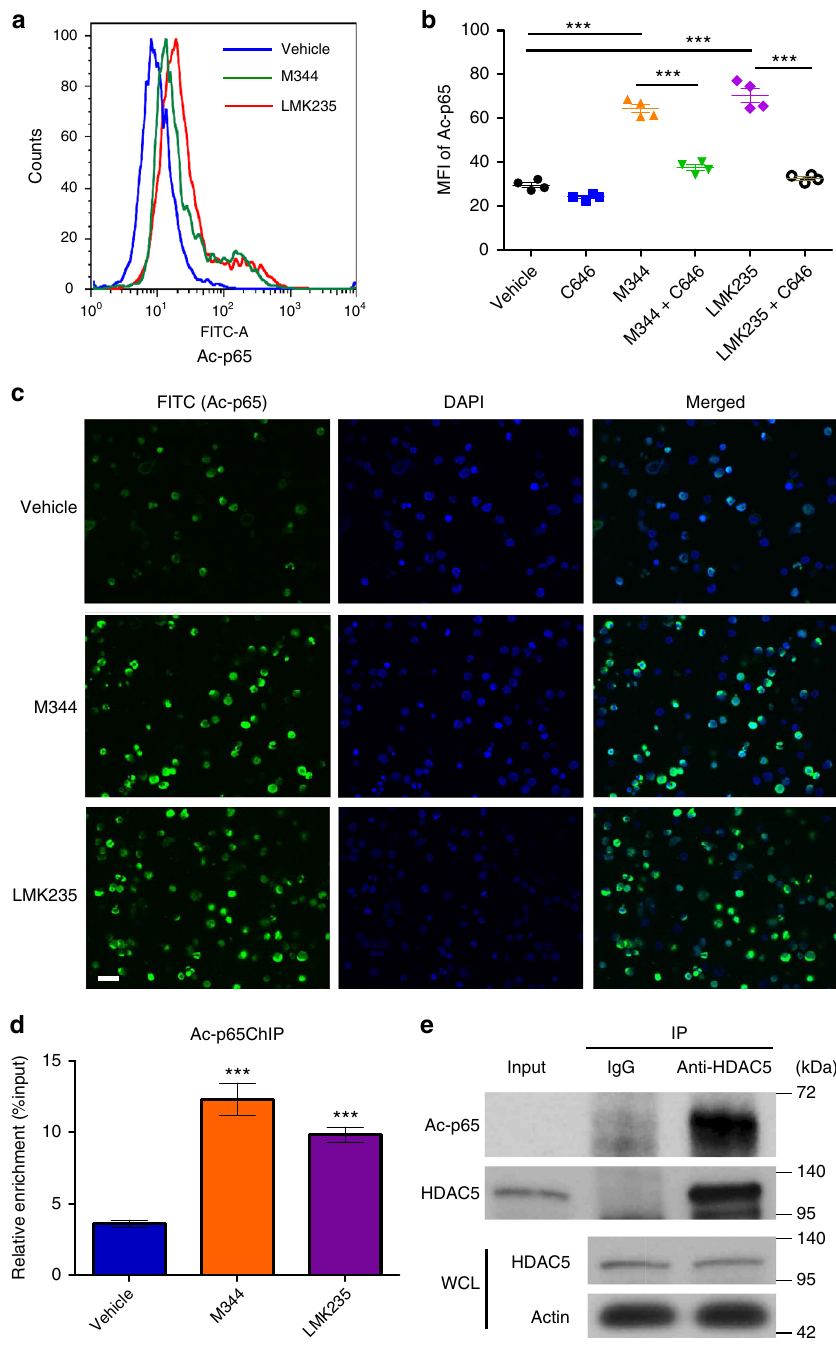
Fig. 6 HDAC5 inhibition results in elevated levels of p65 acetylation. a Histogram of intracellular acetylated p65 (Ac-p65) levels of human CB CD34 + cells treated with vehicle, M344, or HDAC5 inhibitor LMK235. Representative histogram from three independent experiments is shown. b Mean fl uorescence intensity (MFI) of intracellular acetylated p65 (Ac-p65) levels in vehicle, C646 (50 μ M), M344-, M344 + C646-, LMK235-, LMK235 + C646-treated human CB CD34 + cells, as assessed by fl ow cytometry. Data pooled from two independent experiments are shown ( n = 4, one-way ANOVA, *** p < 0.001). c Confocal imaging analysis of intracellular acetylated p65 (Ac-p65) levels of human CB CD34 + cells treated with vehicle, M344, or LMK235. Green indicates intracellular acetylated p65 staining; DAPI (blue) labels the cell nucleus. Representative images from two independent experiments are shown. Scale bar: 20 μ m. d Acetylated p65 levels on CXCR4 promoter in vehicle-, M344-, or LMK235-treated human CB CD34 + cells, as assessed by a ChIP assay. Data pooled from two independent experiments are shown ( n = 6, one-way ANOVA, *** p < 0.001). e HDAC5 IP samples blotted with an anti- acetylated p65 antibody. HDAC5 and actin in the whole cell lysate (WCL) serve as loading controls. For all panels, data are shown as mean ±